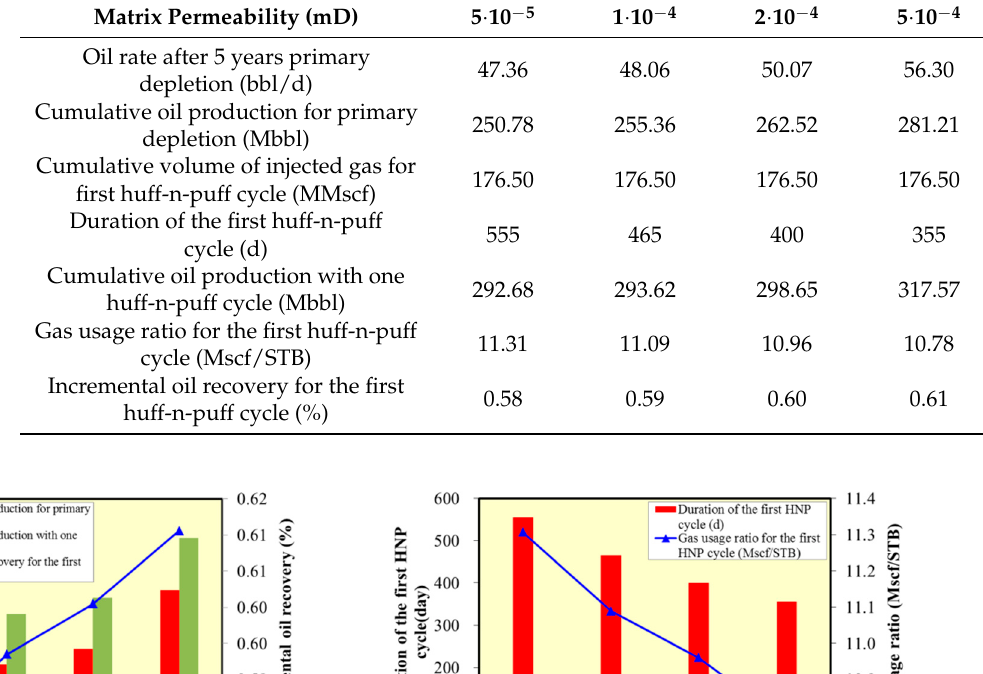
Table 10. Summary of results for huff-n-puff with different matrix permeability.